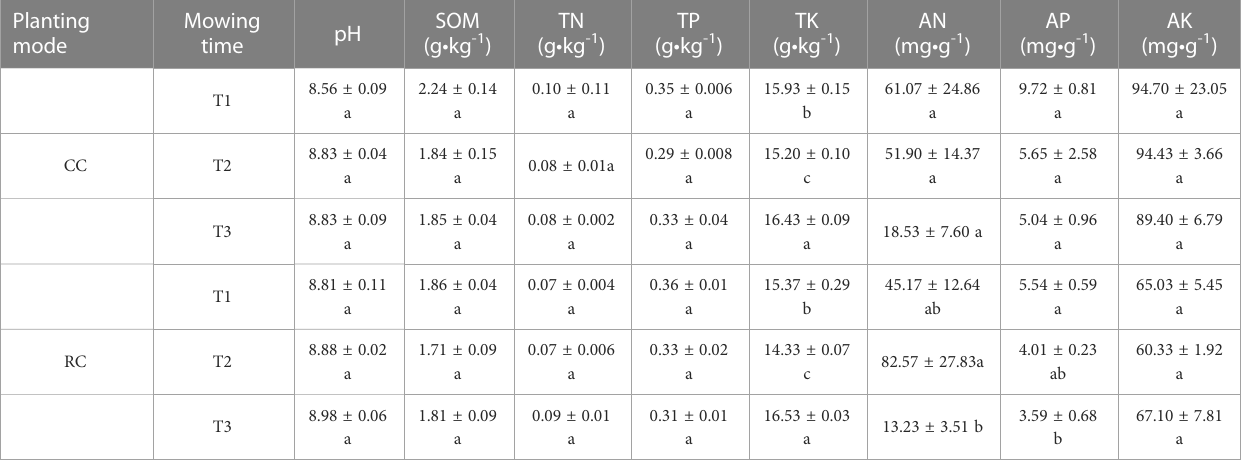
TABLE 2 Soil physical and nutrient